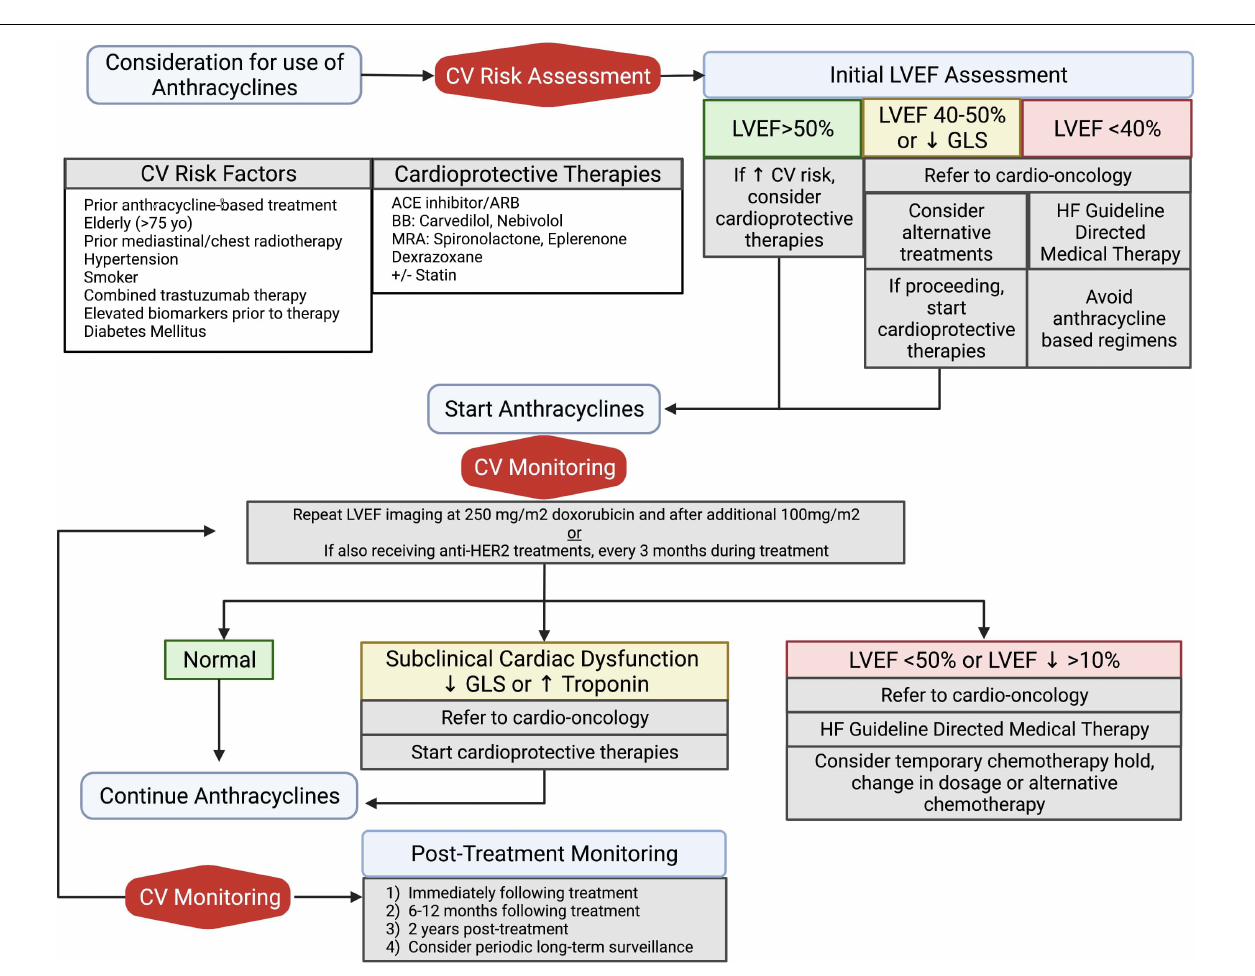
FIGURE 3 | Algorithm of clinical management for prevention and treatment of anthracycline induced cardiotoxicity. All patients should undergo baseline cardiovascular risk assessment, including an echocardiogram. Initiation of cardioprotective medications should be considered in patients with increased cardiovascular risk or abnormal baseline LVEF assessment. Patients with high-risk anthracycline therapy due to high dose (250 mg/m 2 doxorubicin) and concomitant anti-HER2 treatments should undergo serial cardiovascular monitoring during treatment. All patients should undergo post-treatment LVEF monitoring for detection of long-term cardiovascular sequelae. Adapted from ESMO 2020 guidelines (75). ACE, angiotensin converting enzyme; ARB, angiotensin receptor blocker; BB, beta blocker; CV, cardiovascular; GLS, global longitudinal strain; HF, heart failure; LVEF, left ventricular ejection fraction; MRA, mineralocorticoid receptor antagonist. Created with